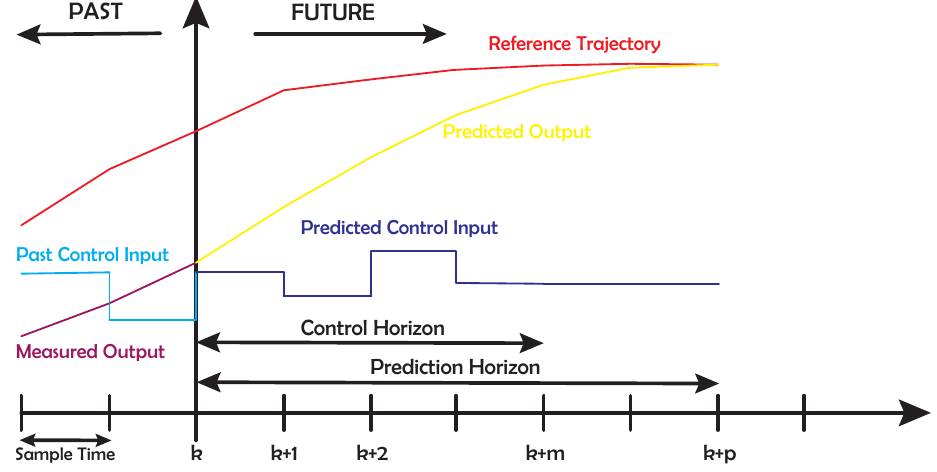
Figure 9. Model predictive control (MPC) future prediction